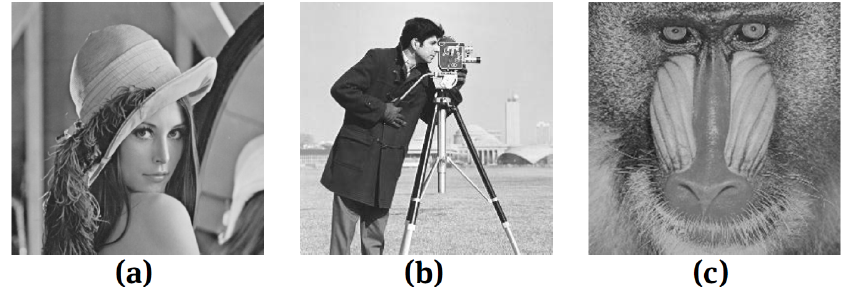
Figure 5. The cover images used in the conducted experiments. ( a ) Lena. ( b ) Cameraman. ( c ) Baboon.